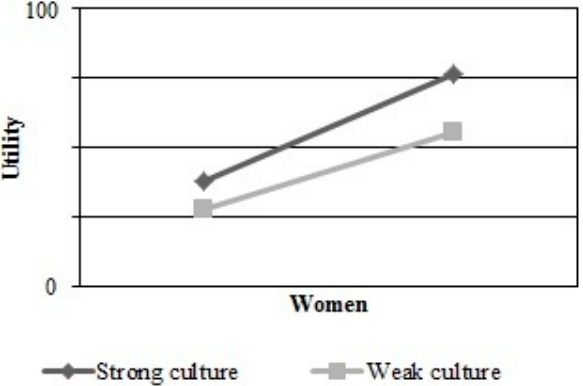
Figure 4. Moderating effect of the cultural context on the link between female directors and Utility variable.